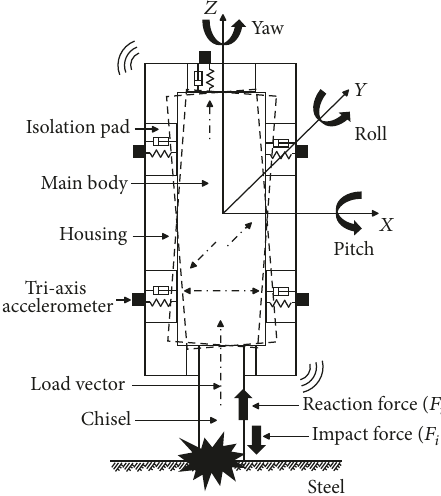
Figure 3: Motion of hydraulic breaker due to impact